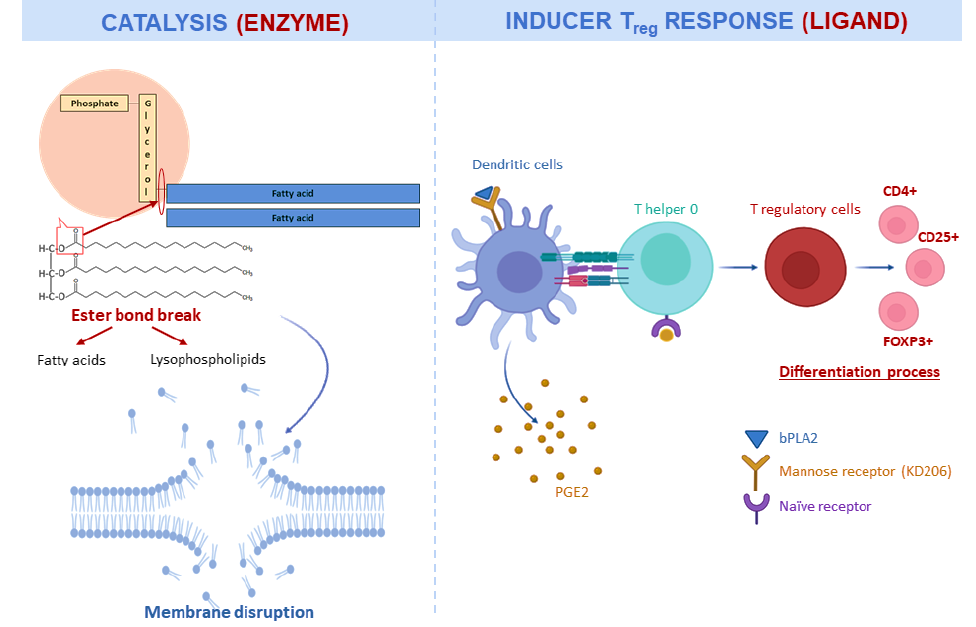
Figure 4. Double behavior of PLA2. This enzyme has the ability of acting as enzyme or as a ligand. As an enzyme, it causes membrane disruption and can exert antimicrobial and cytotoxic effects. As a ligand, it produces cellular signals and modulate immune response.